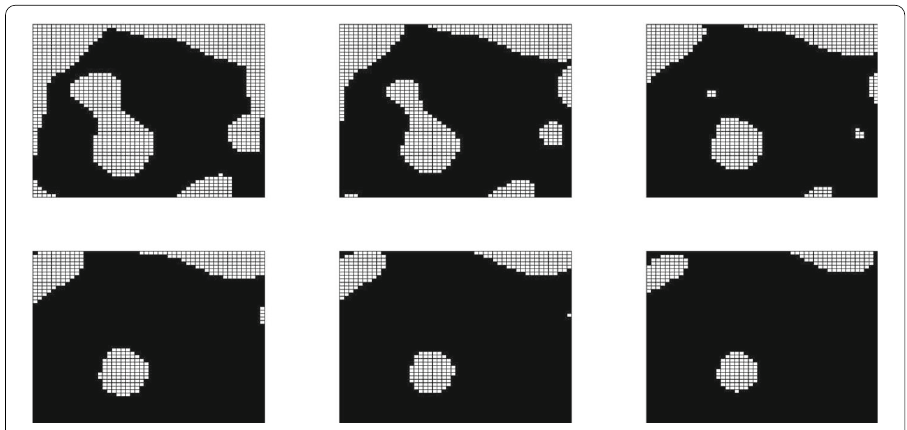
Fig. 19 The presence of damage (elements marked in black) on the meso-scale for one random field realisation with c var = 0 . 1 and (cid:23) c = 10 (cid:23) e w.r.t. time